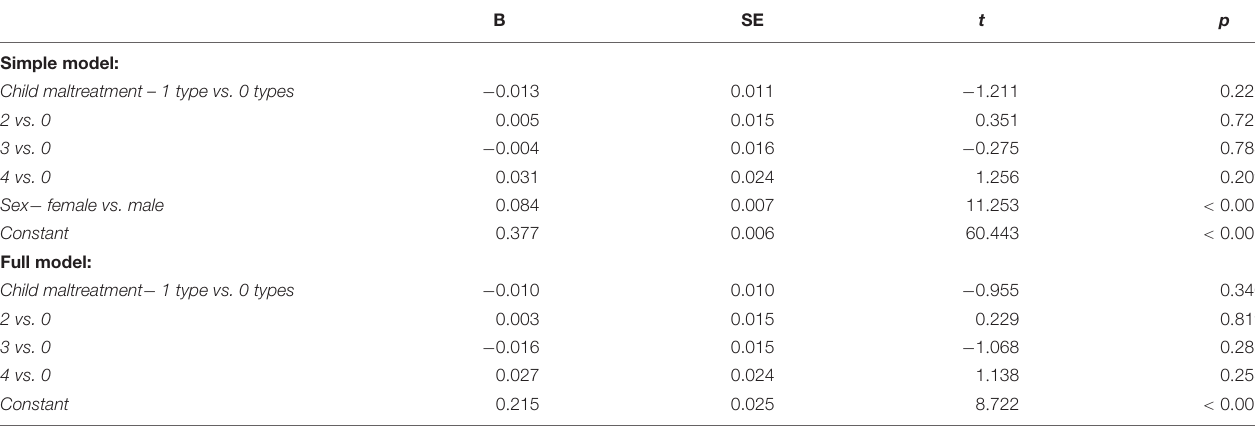
TABLE 6 | Results of the linear regression analysis assessing the association between the number of experienced child maltreatment types and circulating CRP in N = 5,879 participants. B SE t